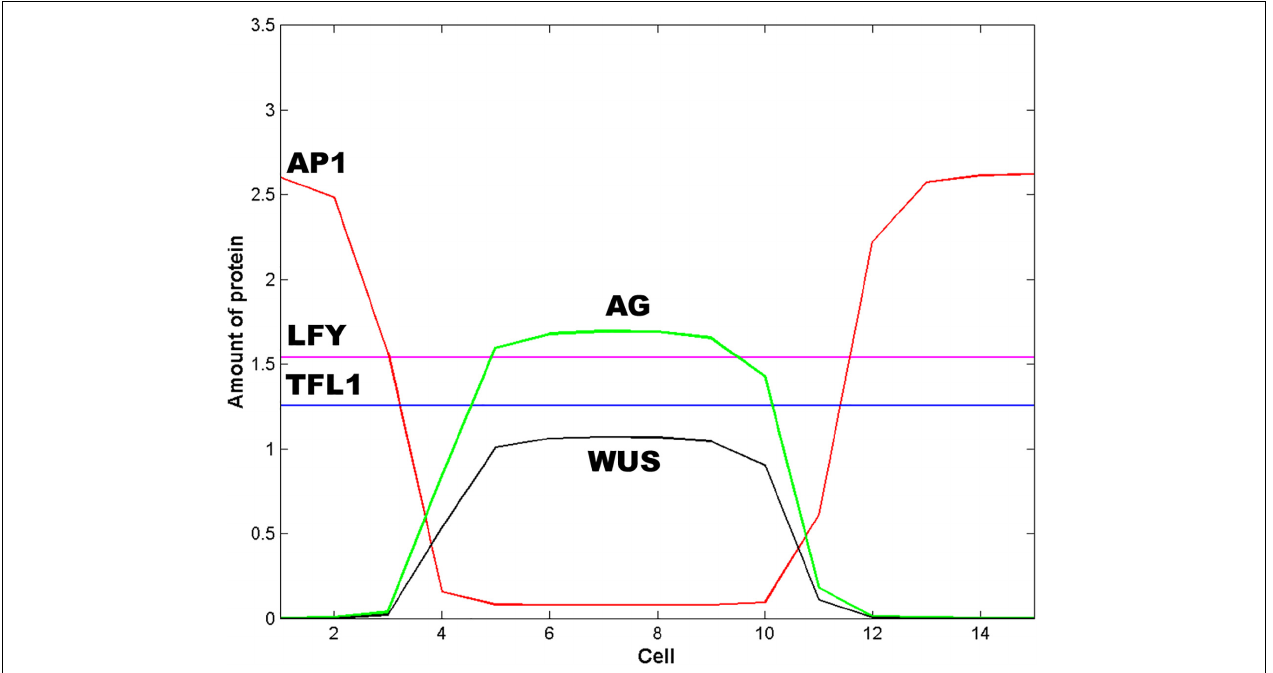
FIGURE 3 | Effect of the spatial extent of the inhibitory signals L and y . In this Figure L = 1 and y = 1 for cells 1 and 15; L = 0 and y = 0 otherwise. The effect of decrease the spatial extent of the inhibitory signals L and y is to pattern the floral meristem into a spatio-temporal stable dissipative structure, which becomes broader and asymmetric with respect to cell 8 and resembles an altered floral structure. In this Figure t = 16 h and ε = 5.